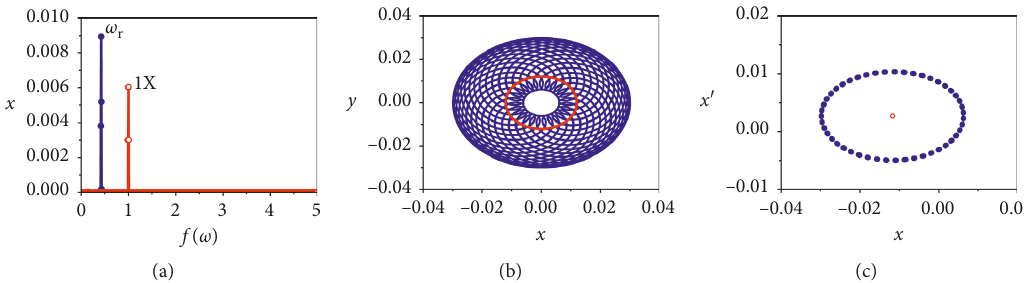
Figure 10: The response of the rotor/seal system with the DVA at s the rotor. (c) The Poincar ´ e map of the x coordinate.